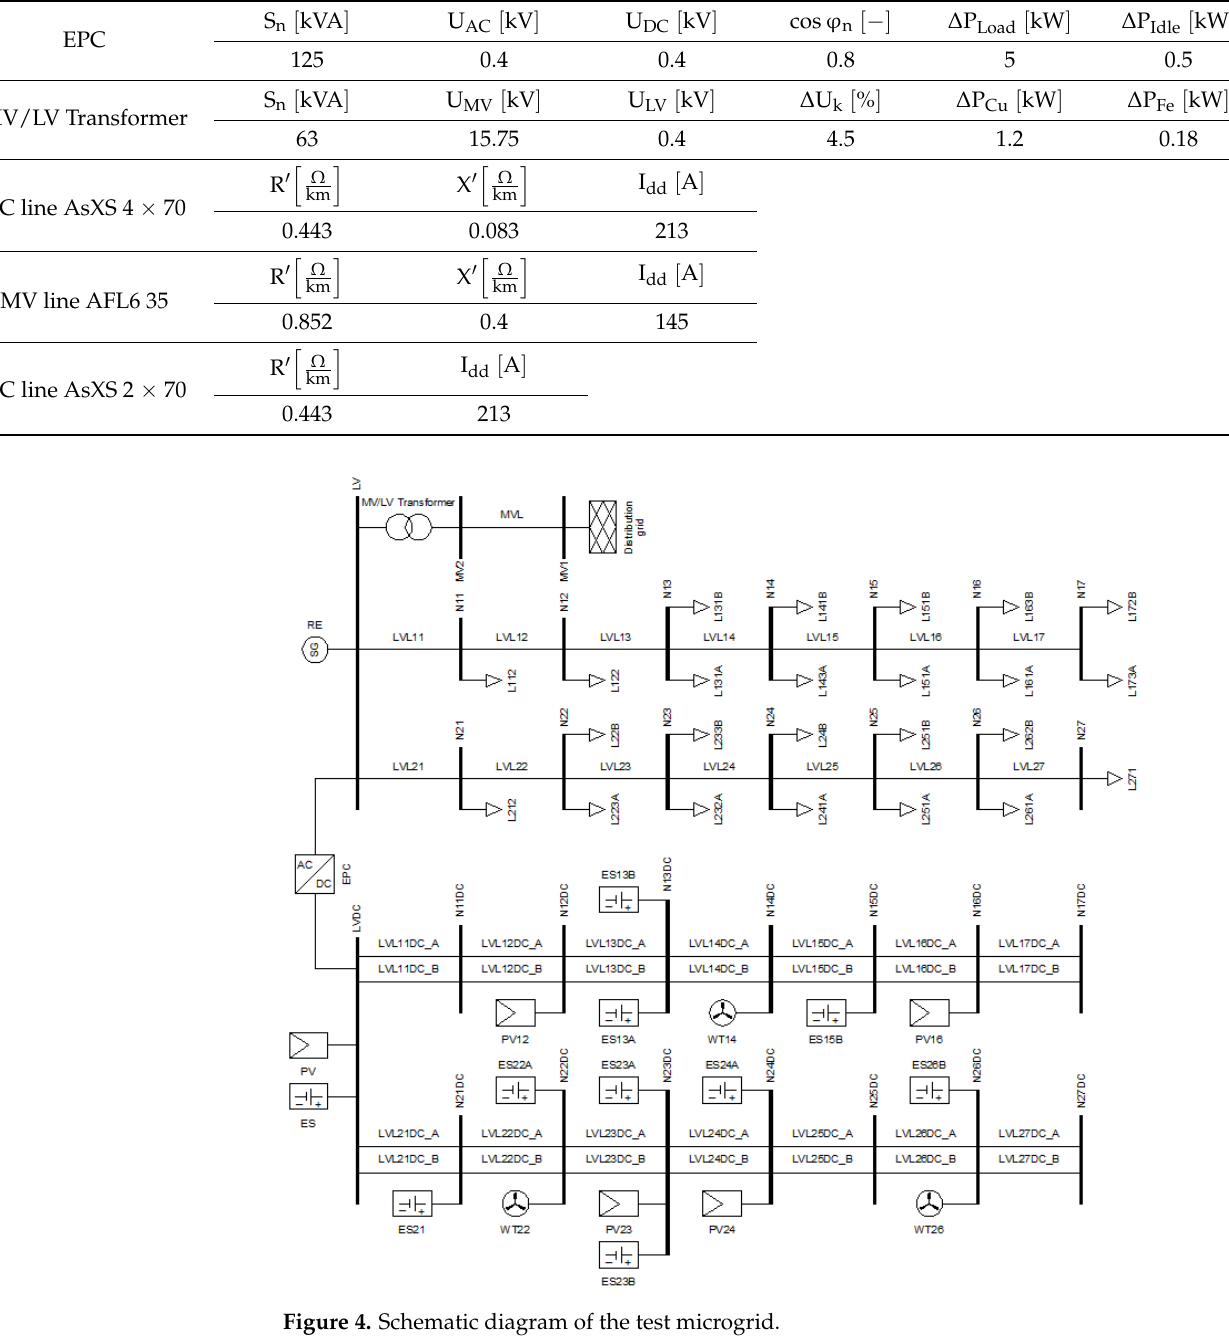
( b ) Figure 5. ( a ) Total daily active power demand characteristics of the test microgrid; ( b ) Total daily reactive power demand characteristics of the test microgrid. 01020 30 4050 0:00